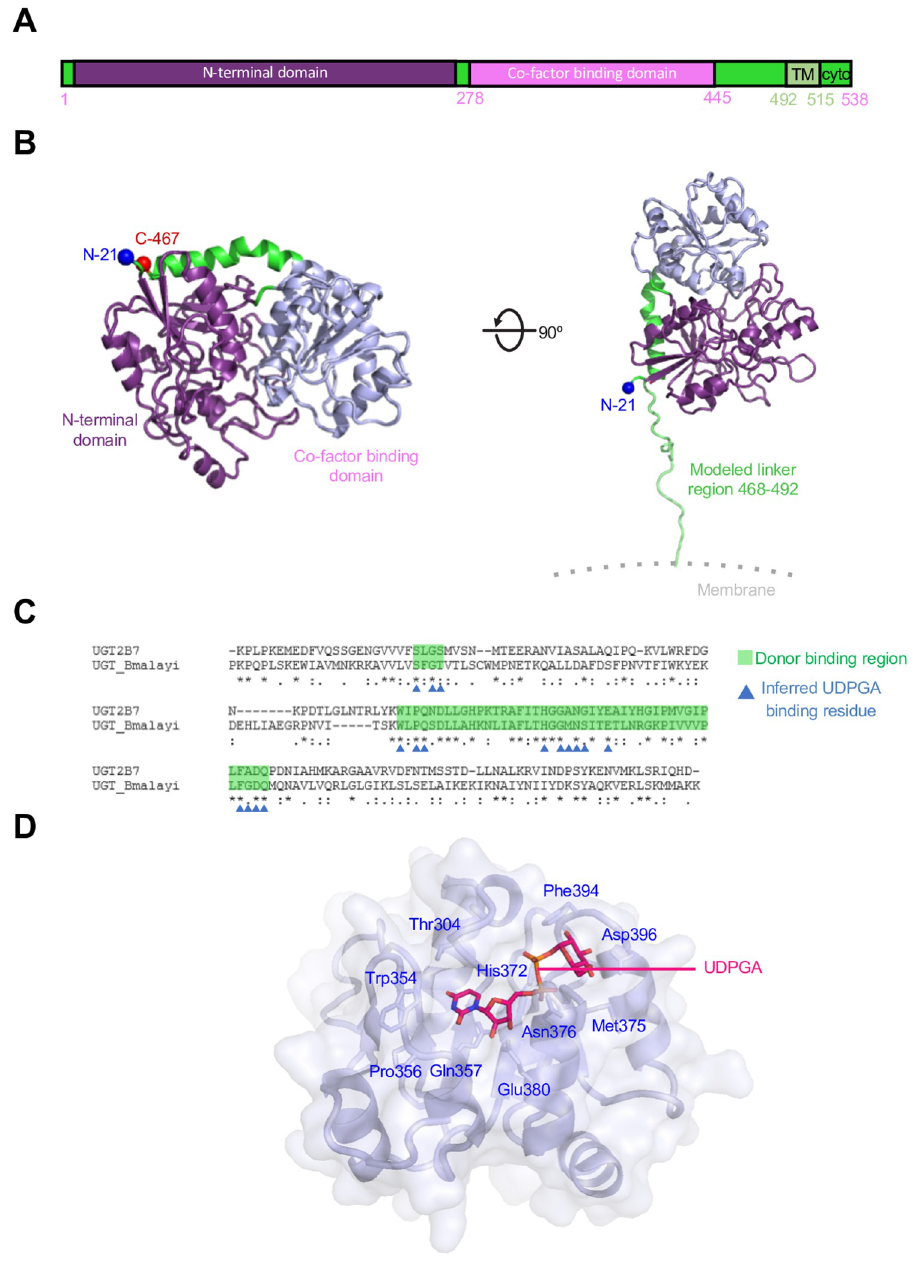
Fig 2. Structural analysis of filarial B . malayi intestinal UDP-glucuronosyltransferase (Bm - UGT). (A) Schematic representation of the Bm-UGT protein domains. (B) Structure model of the UDP-glucuronosyltransferase generated using SWISS-MODEL and PDB ID: 5NLM (UDP-glucosyltransferase from Polygonum tinctorium ). The structure has a N-terminal domain (purple) and a co-factor binding domain (grey) with linker residues 468–492 modelled (right). (C) Sequence alignment of UGT2B7 C-terminal domain (PDB ID: 2O6L) with the filarial Bm-UGT C-terminal domain. Putative co-factor binding residues are indicated based on sequence and structural homology. (D) Structure of the co-factor binding domain is shown with transparent surface representation and inferred UDPGA-interacting residues shown in stick representation and labeled. The UDPGA location is modelled based on the plant glycosyltransferase Medicago truncatula UGT71G1—UDP-glucose structure (PDB ID: 2ACW).